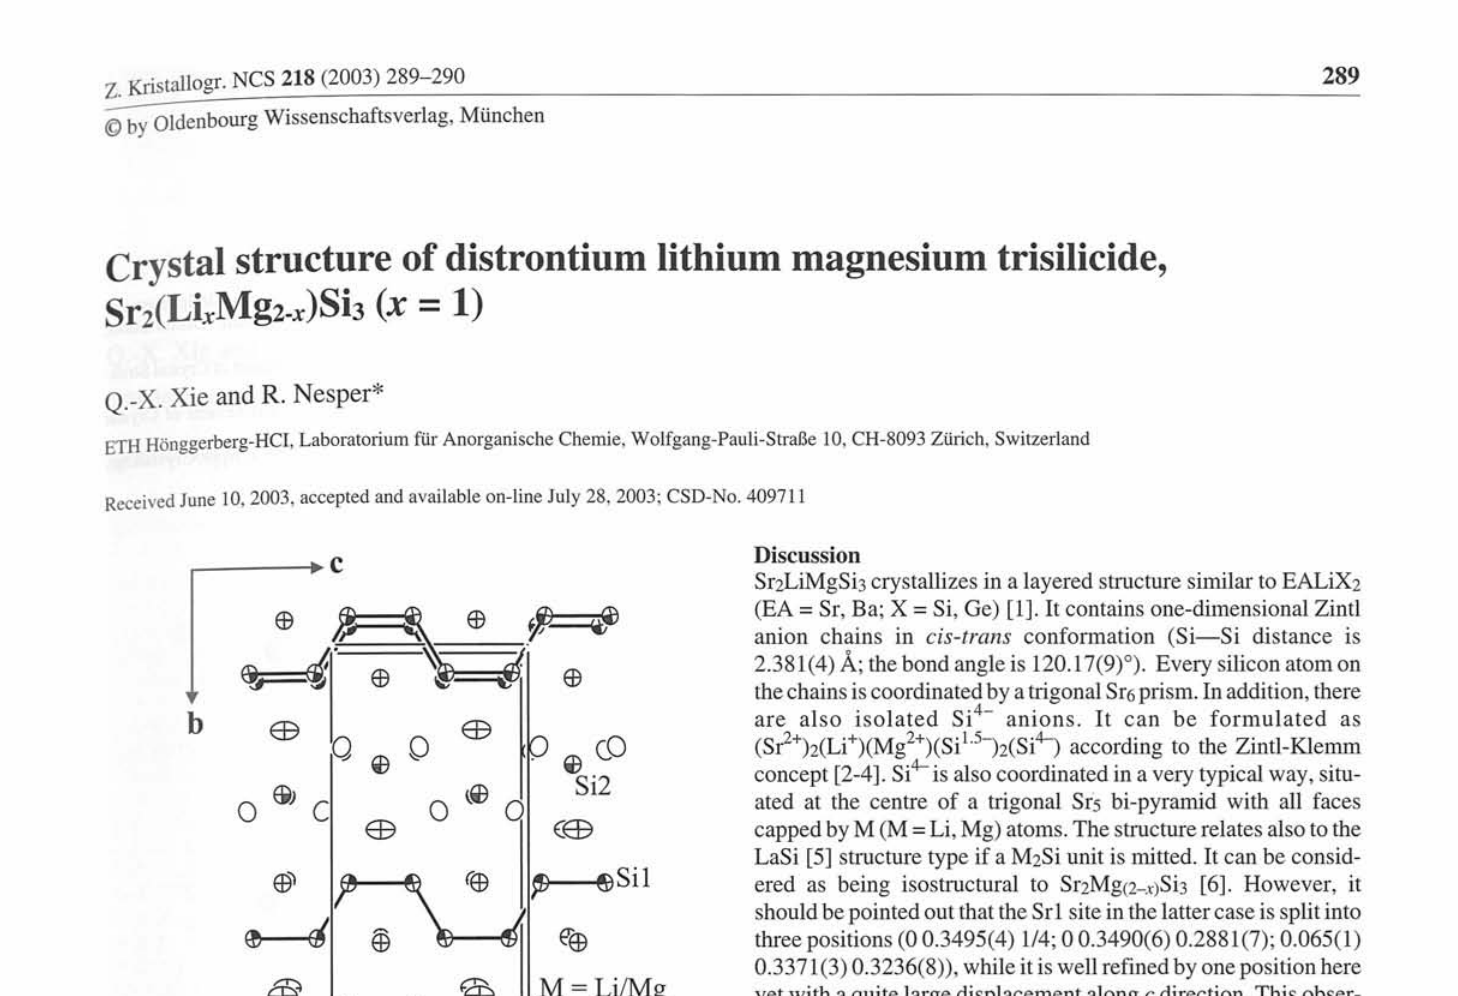
Table 1. Data collection and handling.